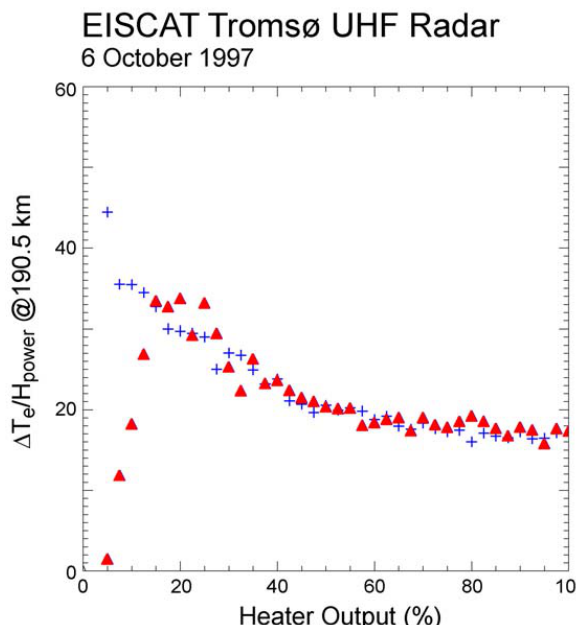
Fig. 7. The temperature change of the electrons in the ionosphere modified by the Tromsø heater normalised by and plotted as a func- tion of the heater output power. Again the up- and down-going parts (respectively symbolised by 1 and +) of the heater cycle are over- laid to illustrate the hysteresis effect (reproduced from Wright et al., 2006).